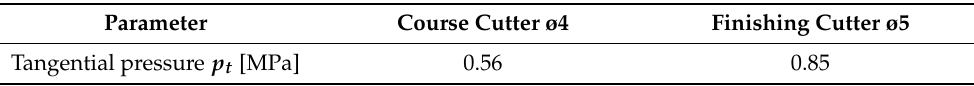
Table 5. The determined values of the tangential pressure p t for the two cutters